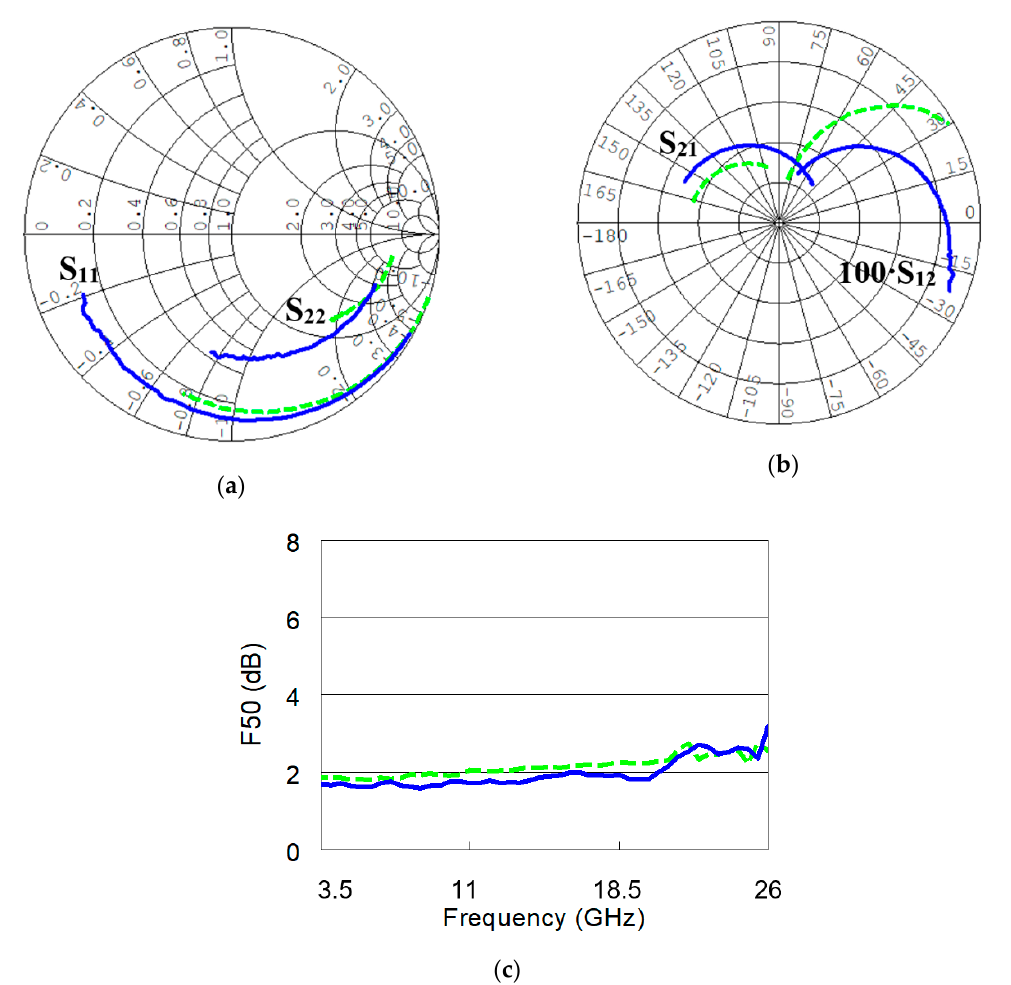
Figure 6. Scattering parameters measured by NRL (green dashed line) and UniME (blue solid line) for a HEMT with gate width of 2 × 50 μ m (3.5–26 GHz). ( a ) S 11 and S 22 , ( b ) S 21 and 100 · S 12 , ( c ) F 50 . V DS = 2 V and I DS = 20 mA.